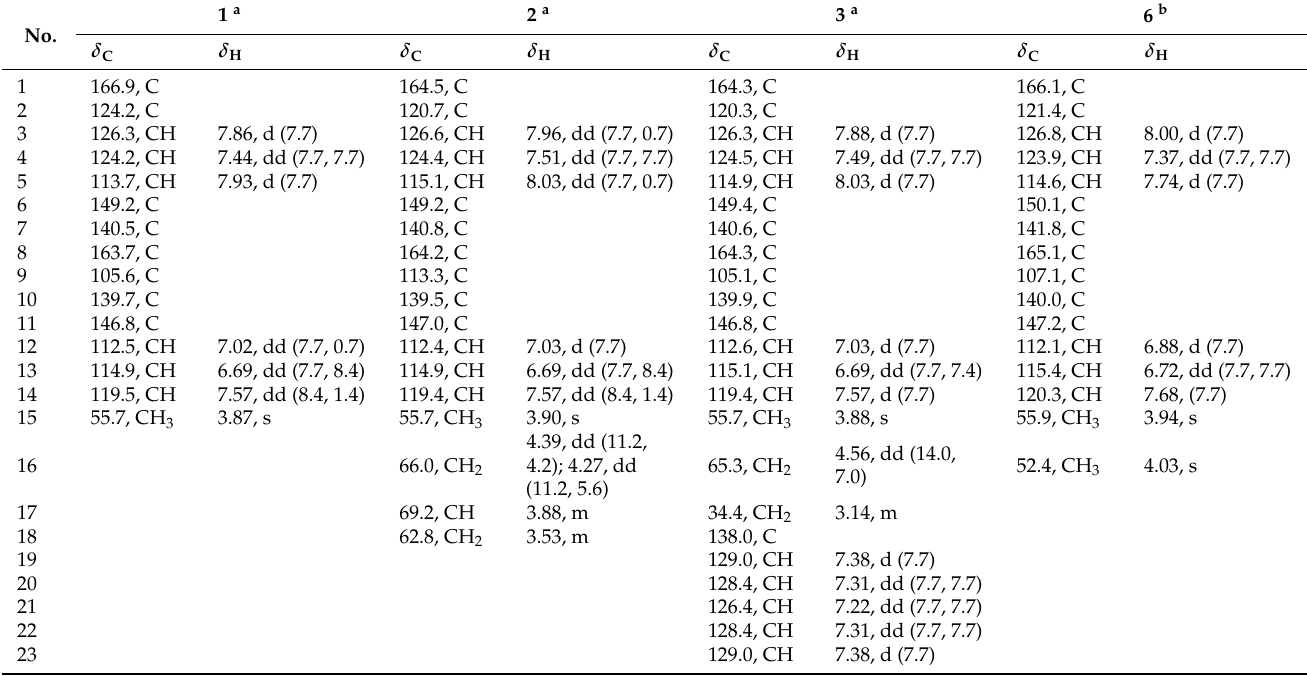
Table 1. The NMR data of compounds 1 – 3 and 6 ( J in